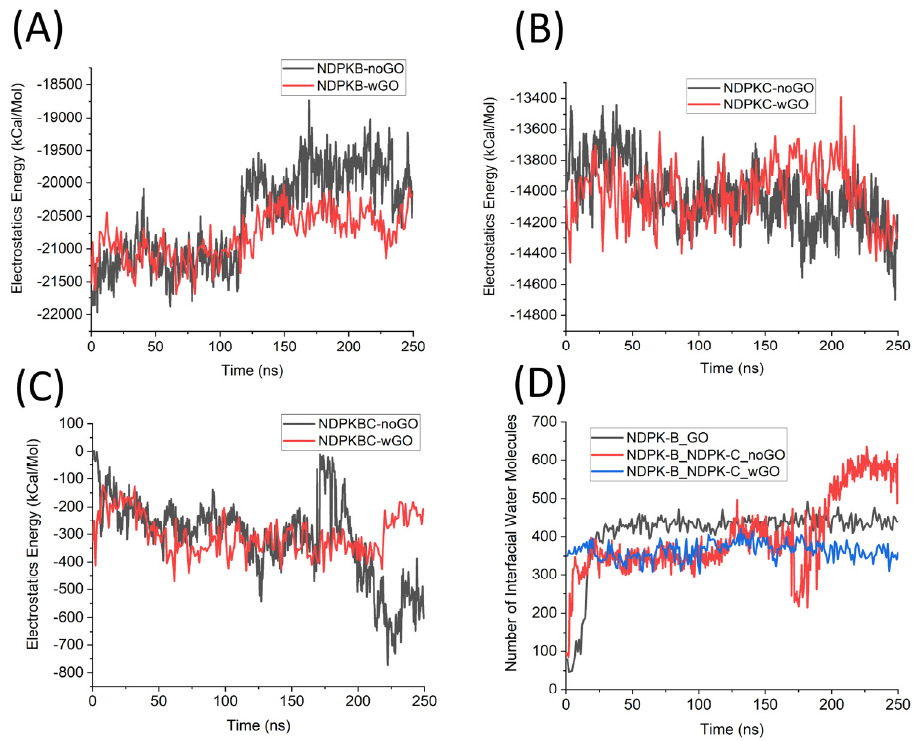
Figure 4. Electrostatics energy and role of interfacial water molecules: ( A ) Electrostatics energy within NDPK-B in the presence and absence of GO; ( B ) Electrostatics energy within NDPK-C in the presence and absence of GO; ( C ) Electrostatics energy between NDPK-B and NDPK-C in the presence and absence of GO; ( D ) Number of interfacial water molecules between NDPK-B and GO, and between NPDK-B and NDPK-C in the presence and absence of